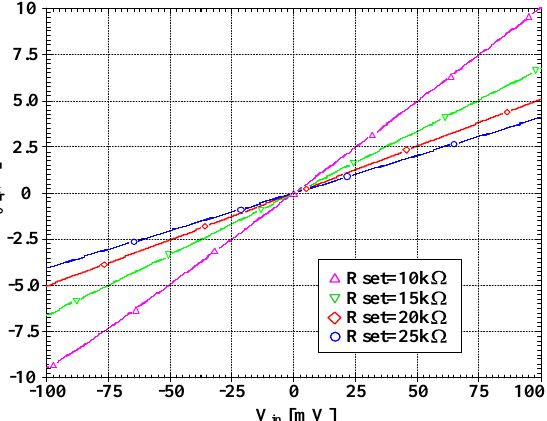
Figure 6. The simulated large-signal DC transfer characteristic I o = f(V in ) for different values of R set .